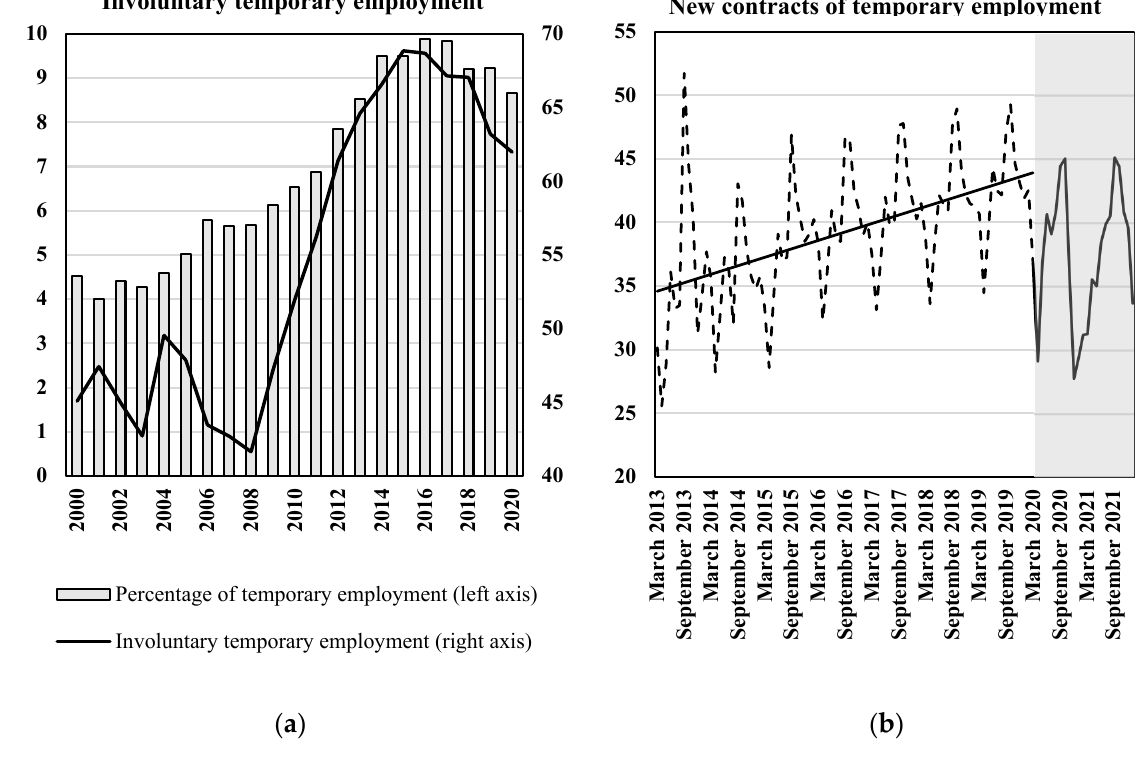
Figure 4. New contracts of temporary employment as a percentage share of total new employment contracts ( a ) and involuntary temporary employment ( b ), Greece. Source: Ministry of Labour and Social Affairs, ELSTAT and authors’ calculations.